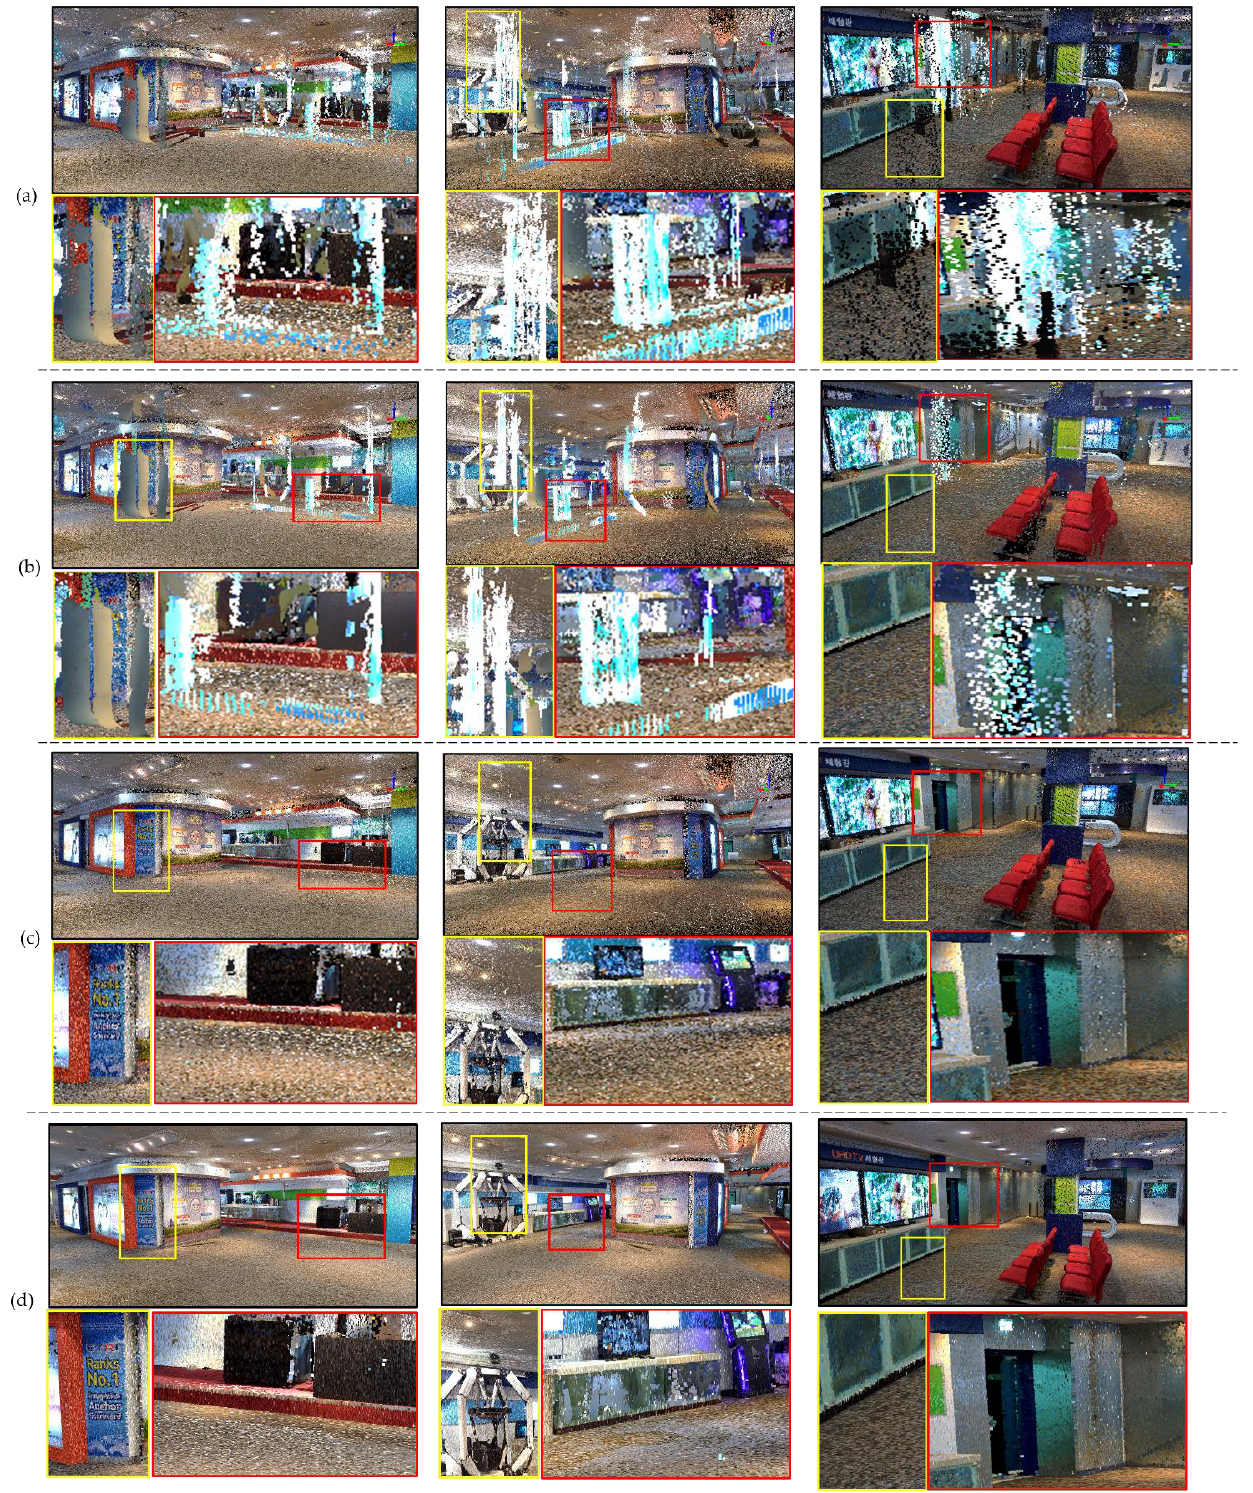
Figure 9. Comparison of the noise results. ( a ) is the original point cloud, ( b ) is the result after processing with FARO, ( c ) is the result obtained from the MPMC method, and ( d ) is the result obtained by our method.